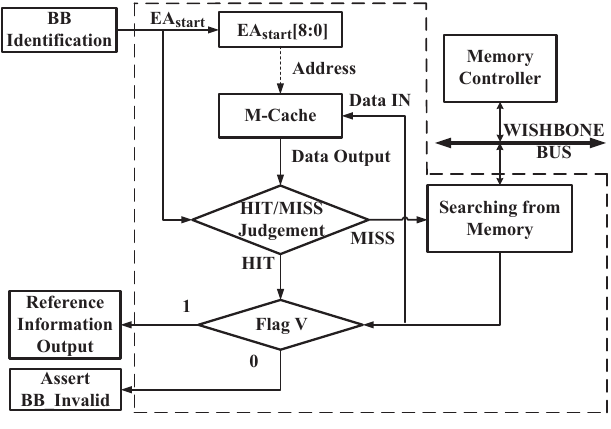
Figure 5. The work flow chart of M-Cache.